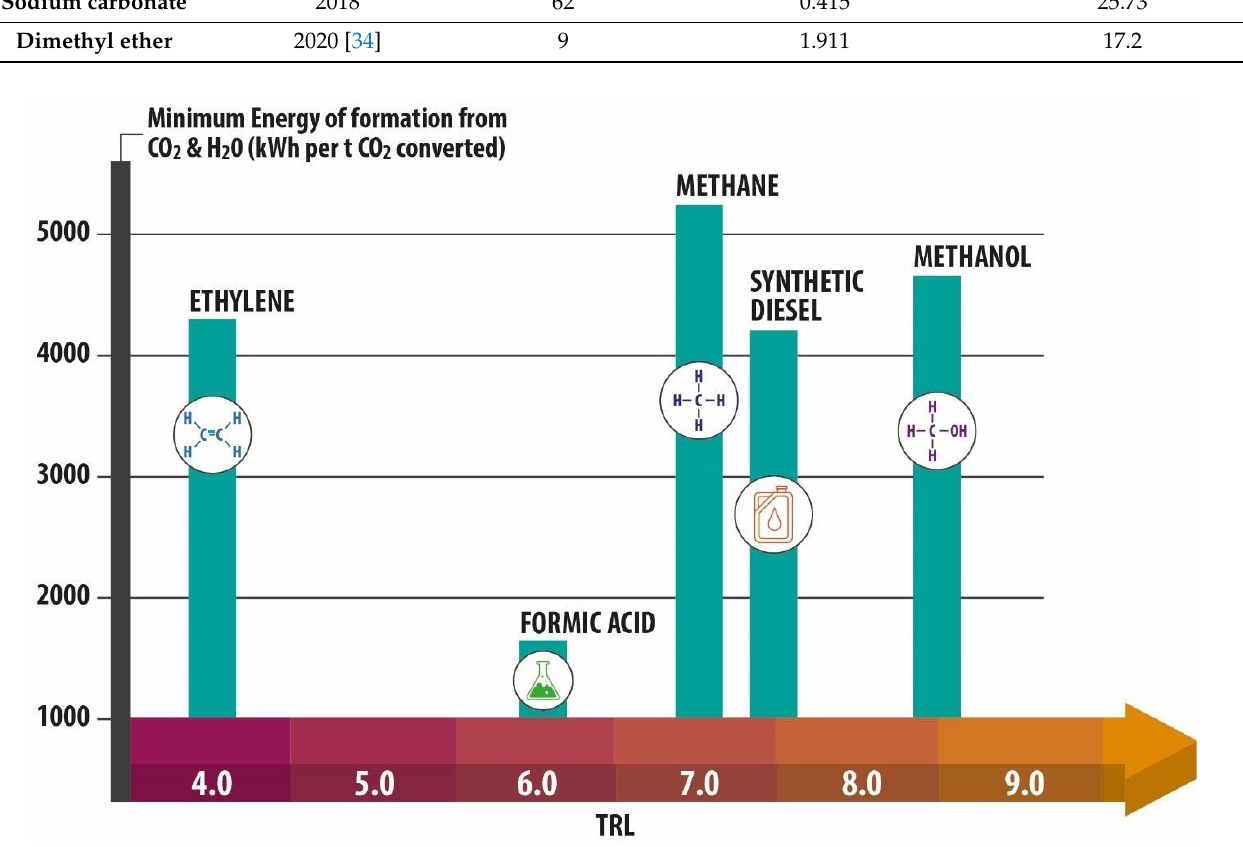
Figure 2. Minimum energy required per ton of CO 2 fixed [35], and TRL for each technology [36].